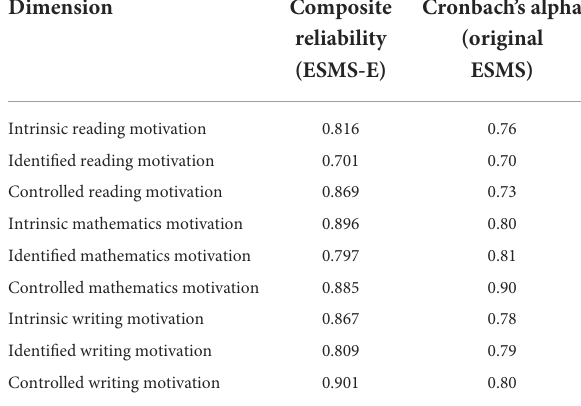
TABLE 3 Descriptive statistics for items and dimensions ( N =